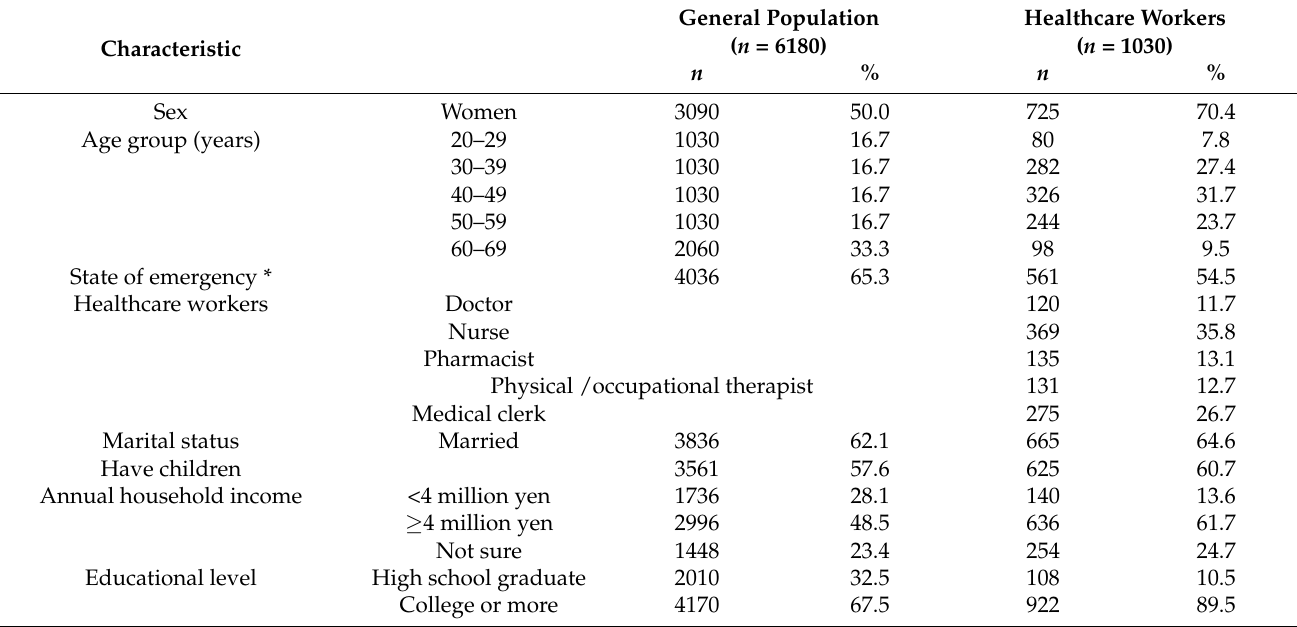
Table 1. Characteristics of study